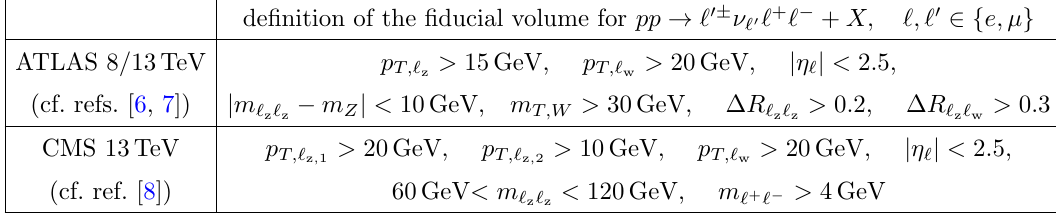
Table 1 . De(cid:12)nition of the (cid:12)ducial volume of the W (cid:6) Z measurements by ATLAS and CMS. While ‘ and ‘ 0 refer to all charged leptons, ‘ z and ‘ w denote the leptons assigned to the Z and W boson decay, according to the procedure described in the text. Numbers in indices refer to p T -ordered particles of the respective